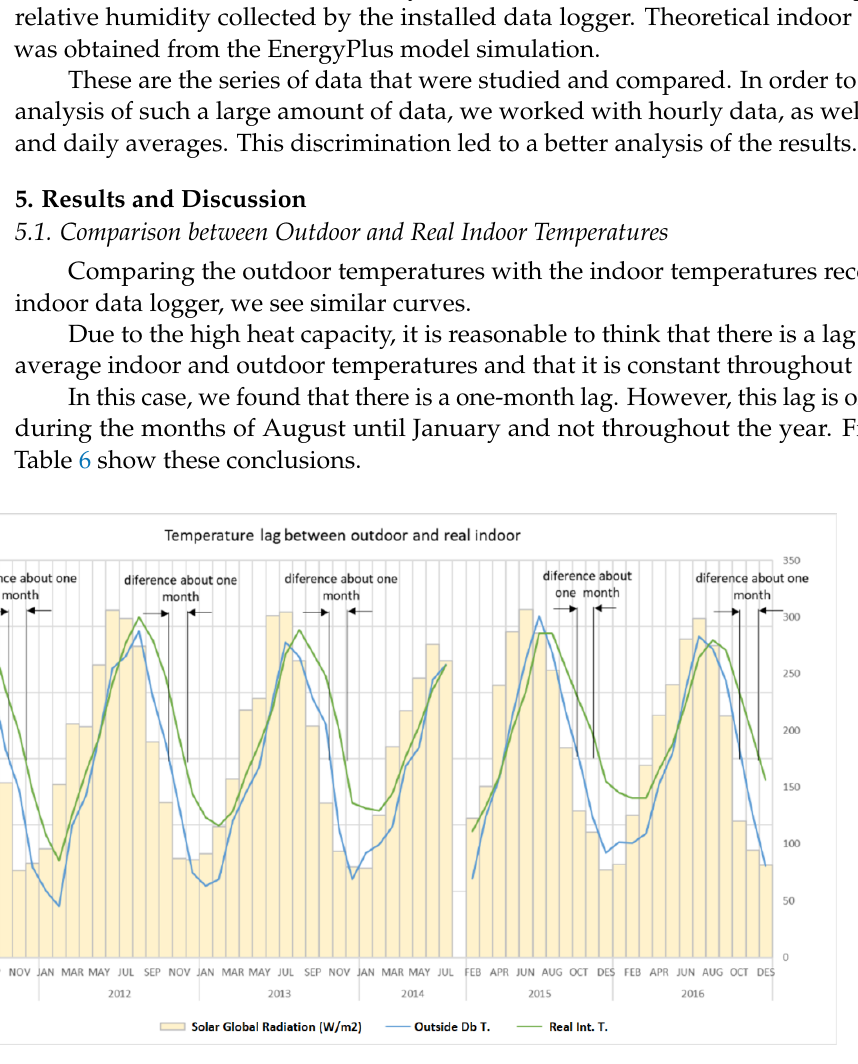
Figure 15. Comparison between average outdoor temperature and real average indoor temperature. Temperature curves are very close in the summer peaks, while the average indoor temperature in winter is always 4–5 degrees above the average outdoor Table 6. Comparison of outdoor and real indoor temperatures for different years.